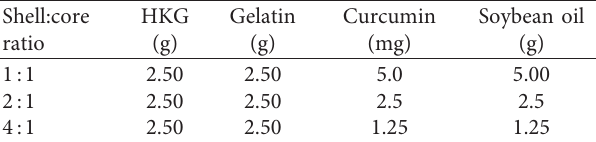
Table 1: Amounts of components used in 1L of final solution for microencapsulation of soybean oil and